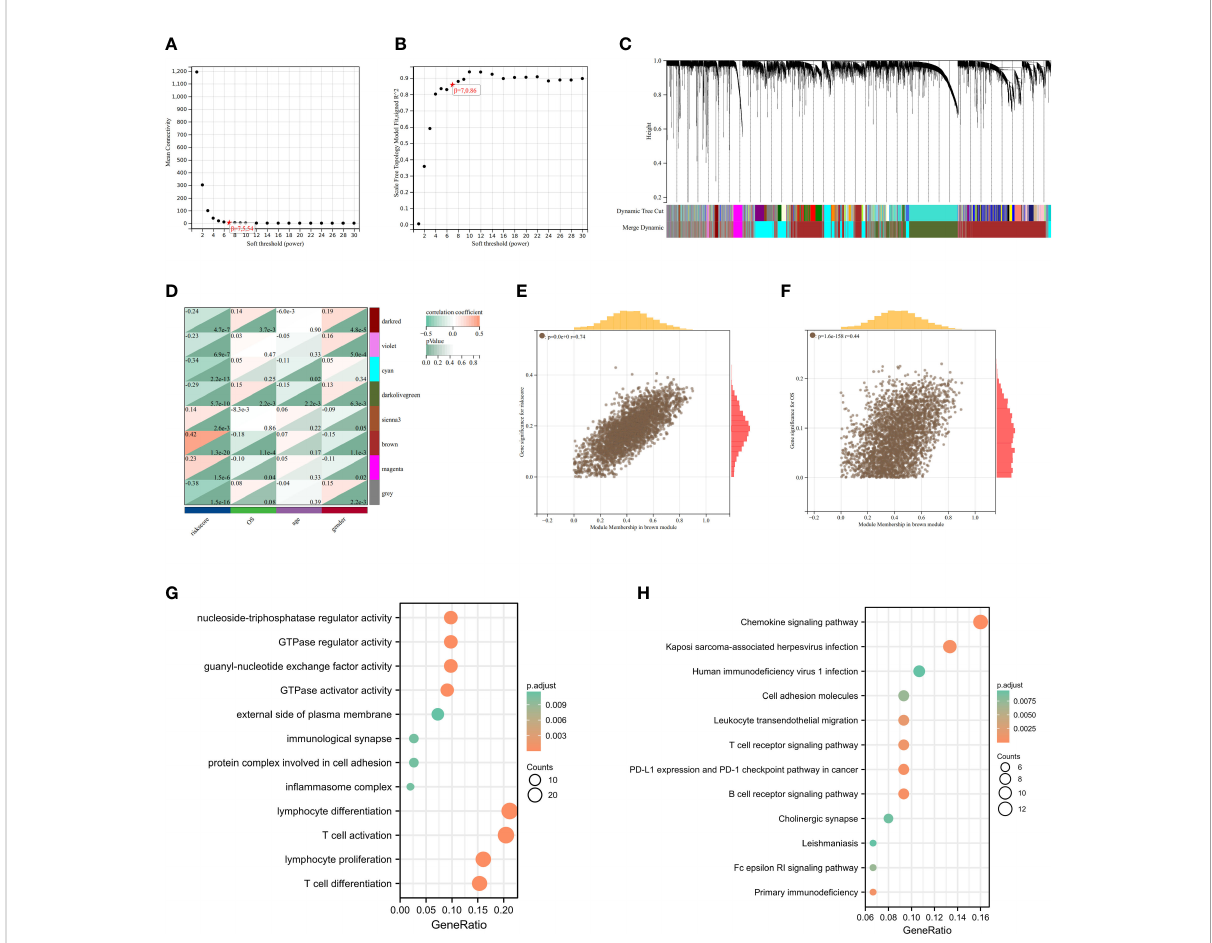
FIGURE 7 Identi fi cation of cuproptosis-related signature via WGCNA. (A) The correlation between soft threshold and scale free topology model fi t signed R2. (B) The correlation between soft threshold and mean connectivity. (C) Clustering of module feature vectors. (D) The correlations between modules and clinical traits were calculated. (E) The high correlation between GS and MM in the brown module in riskscore subgroups. (F) Genes in the brown module were associated with survival status in TCGA. (G) GO enrichment analysis after screening out Hub gene from brown module. (H) KEGG enrichnment analysis after screening out Hub gene from brown